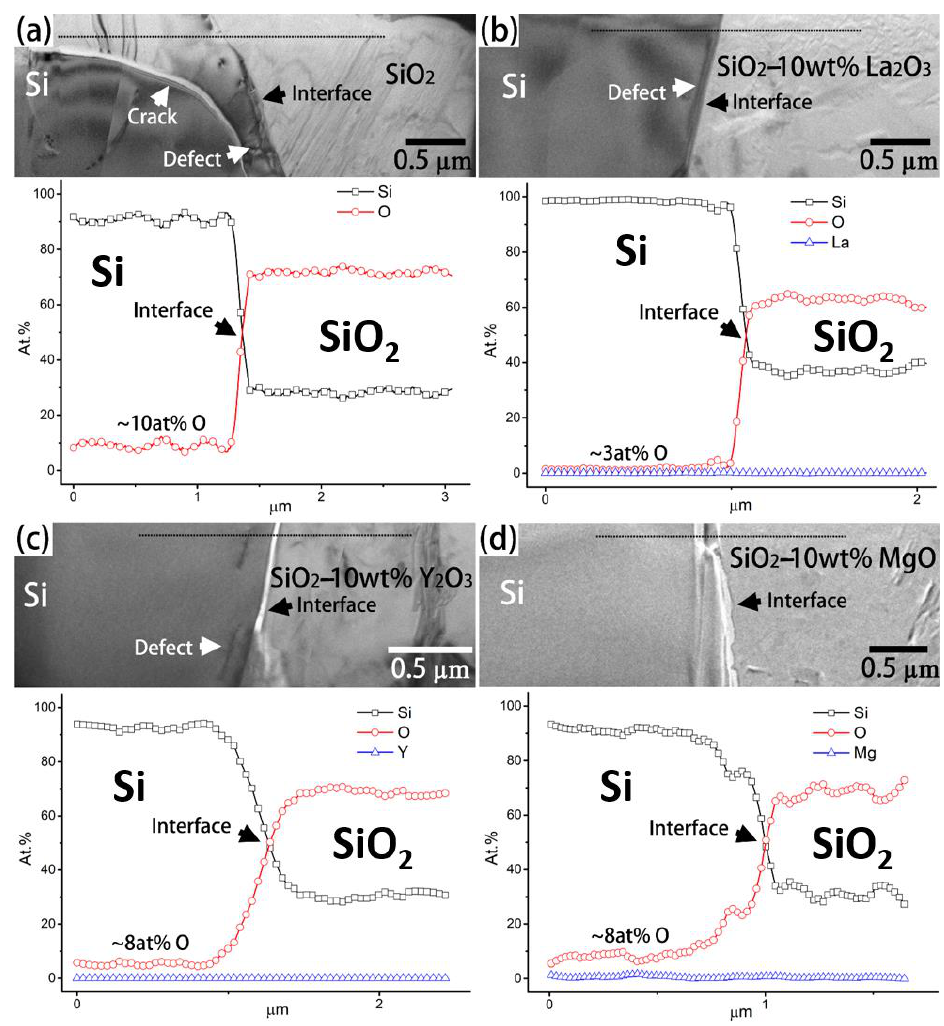
Figure 7. BFIs/TEM images and EDS line scans of ( a ) Si/Si – SiO 2 , ( b ) Si/SiO 2 – 10 wt.% La 2 O 3 , ( c ) Si/SiO 2 – 10 wt.% Y 2 O 3 , and ( d ) Si/SiO 2 – 10 wt.% MgO interfaces.